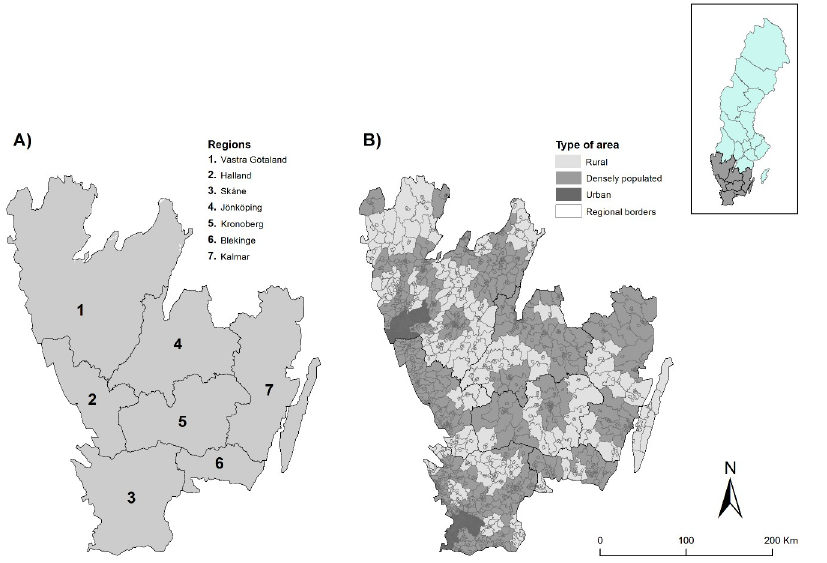
Fig 1. The study area: Southern Sweden. Overview map of the study area. Source: Authors.